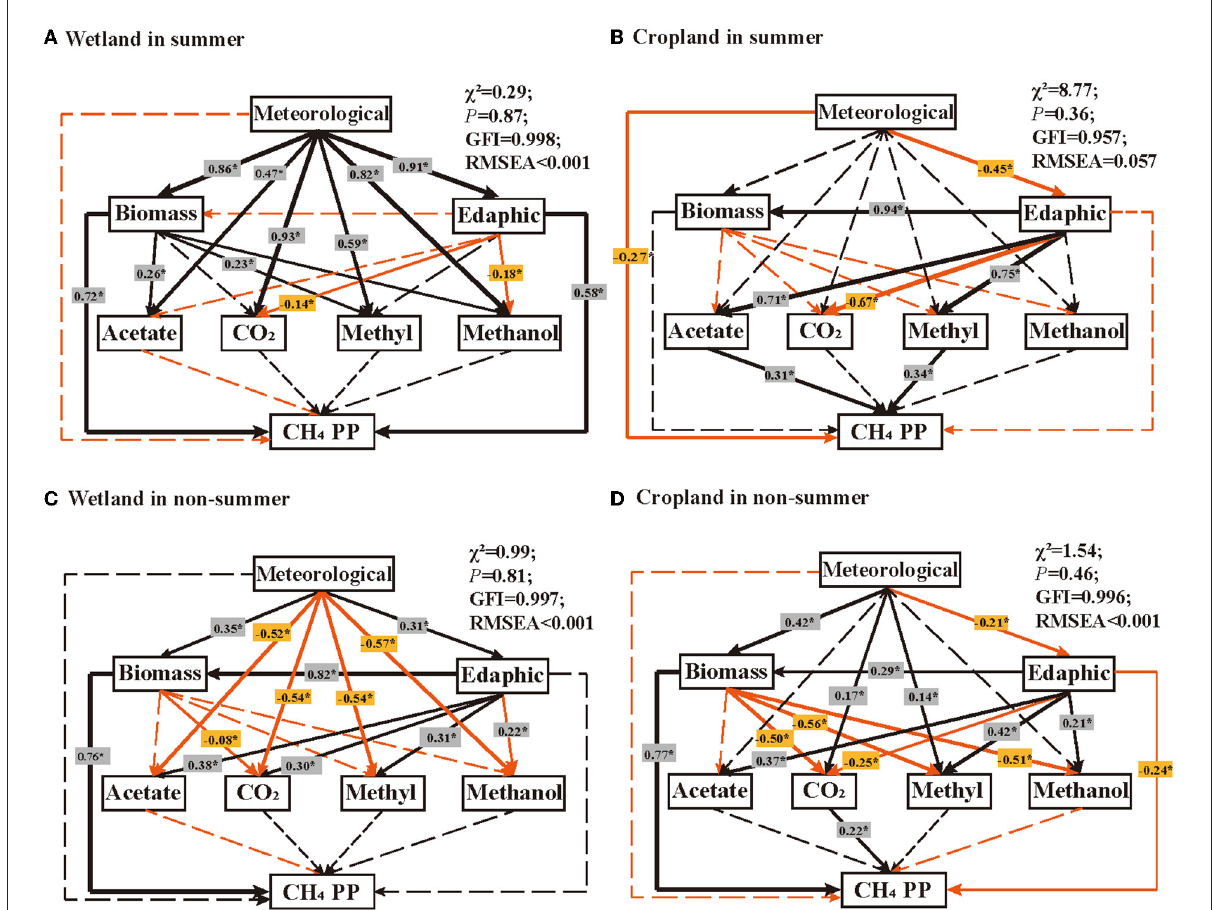
FIGURE5 Structural equation modeling (SEM) illustrating the direct and indirect effects of physicochemical characteristics and functional genes on CH 4 production potential (CH 4 PP) in (A) wetland in summer; (B) cropland in summer, (C) wetland in non-summer, and (D) cropland in non-summer. Meteorologic characteristics refer to soil temperature and soil water content. Edaphic factors included T.C., T.N., T.P., T.S., and C/N ratio. Biomass is referred MBC, MBN, MBP, MBS, and MBC/MBN ratio. Arrows in black and red indicate positive and negative effects, respectively. Solid and dashed lines indicate significant and insignificant correlations, respectively. “*” indicates p < 0.05. R 2 indicates that it appears near every response variable in the model. Model fitness details, including χ 2 , p-value , GFI, and RMSEA, are close to the